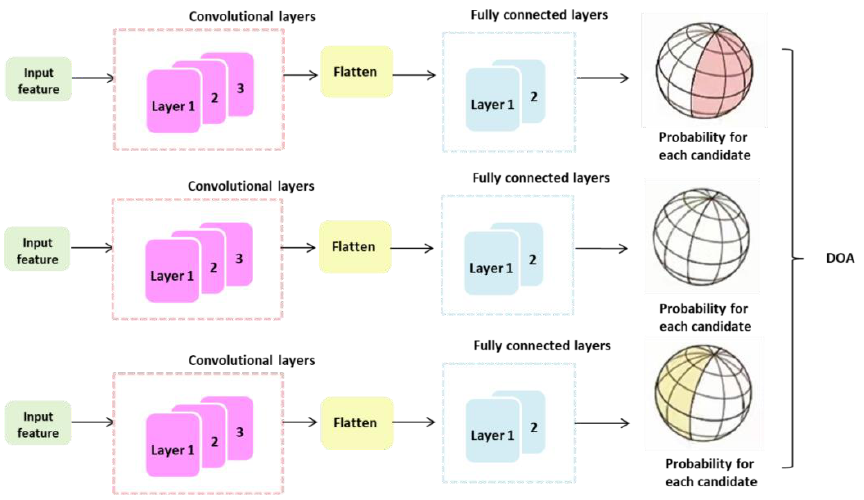
Figure 5. The process for DOA estimation task and architecture in detail for the segmentation